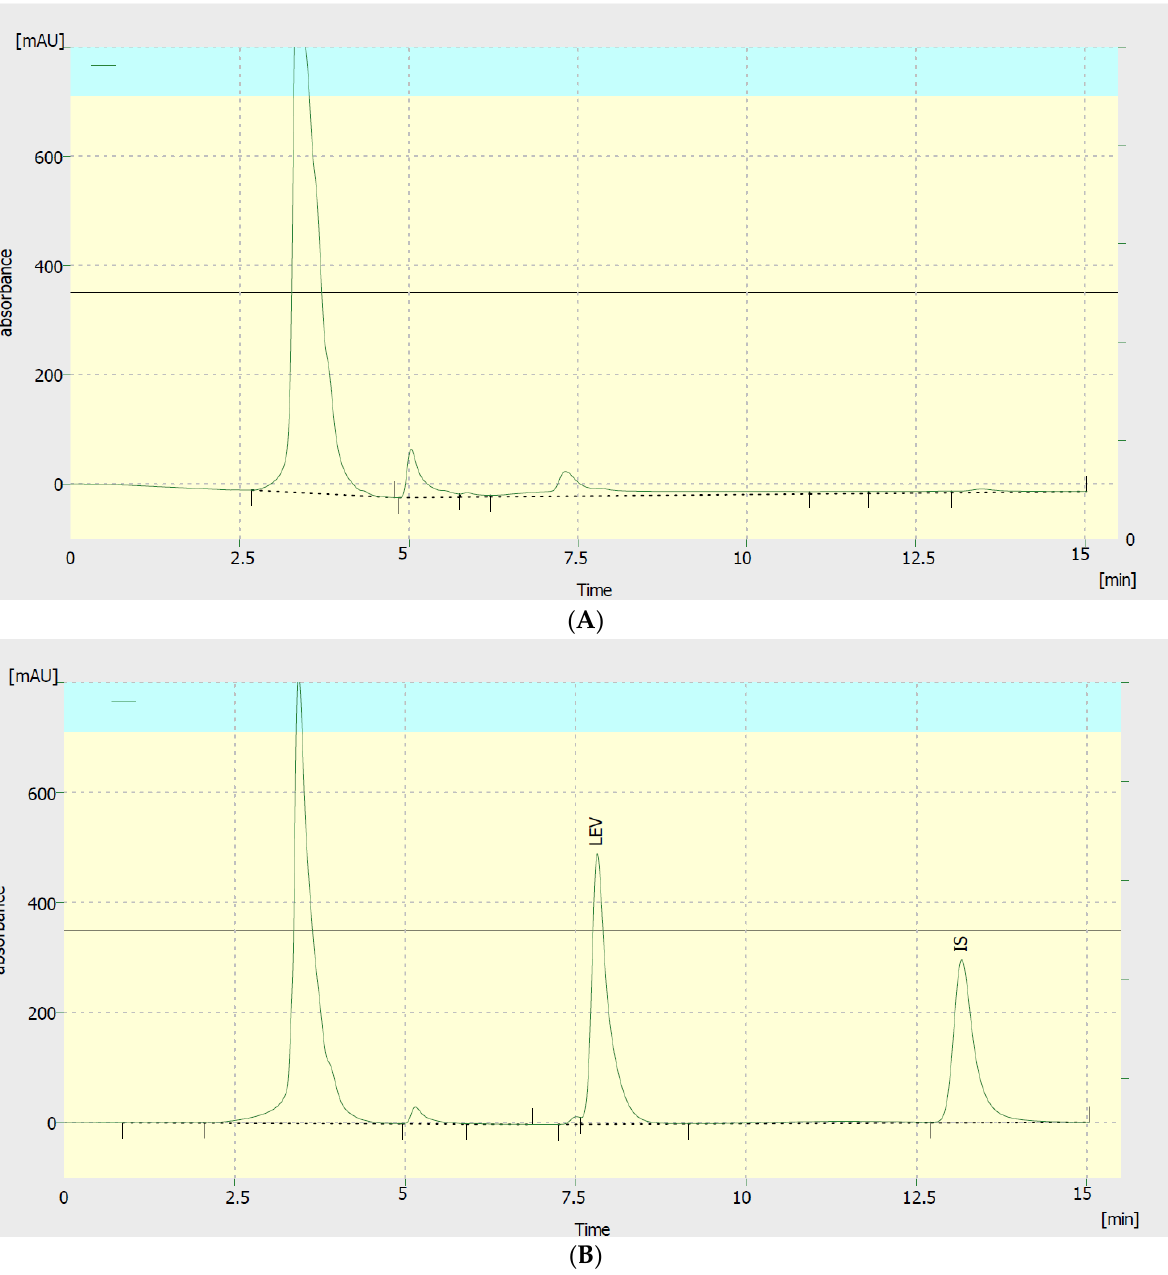
Figure 2. ( A ) A blank plasma chromatogram; ( B ) a chromatogram showing a sample of human plasma spiked with 80 μg/mL levetiracetam (LEV) and caffeine as internal standard (IS). LEV and IS retention times were 7.8 and 13.2 min, respectively.